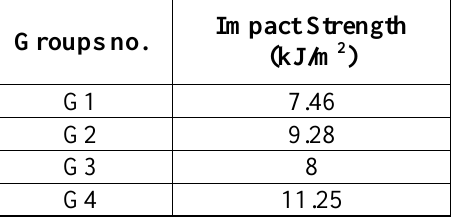
Descriptive information of impact strength values of pure and coated and uncoated chopped fibers